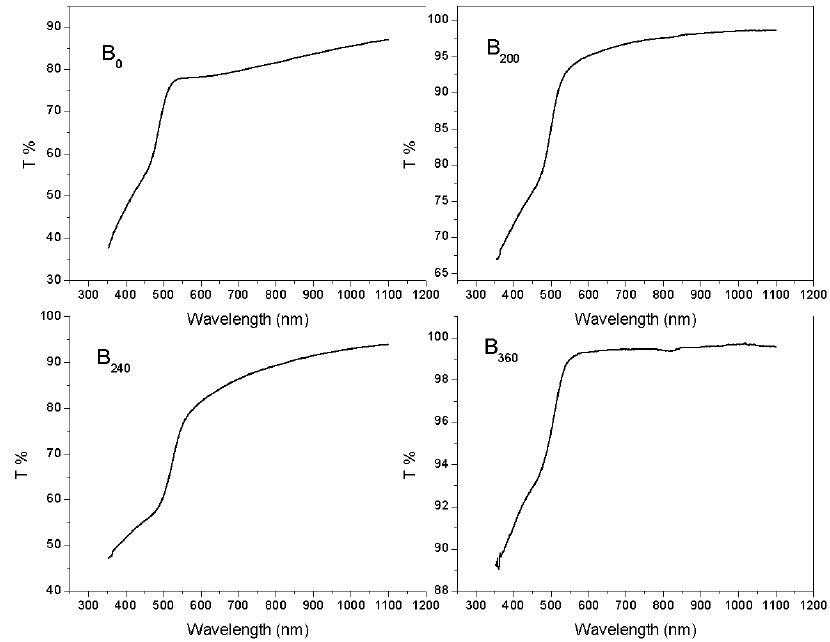
Figure 5. Transmittance spectra for different annealing temperatures for concentration